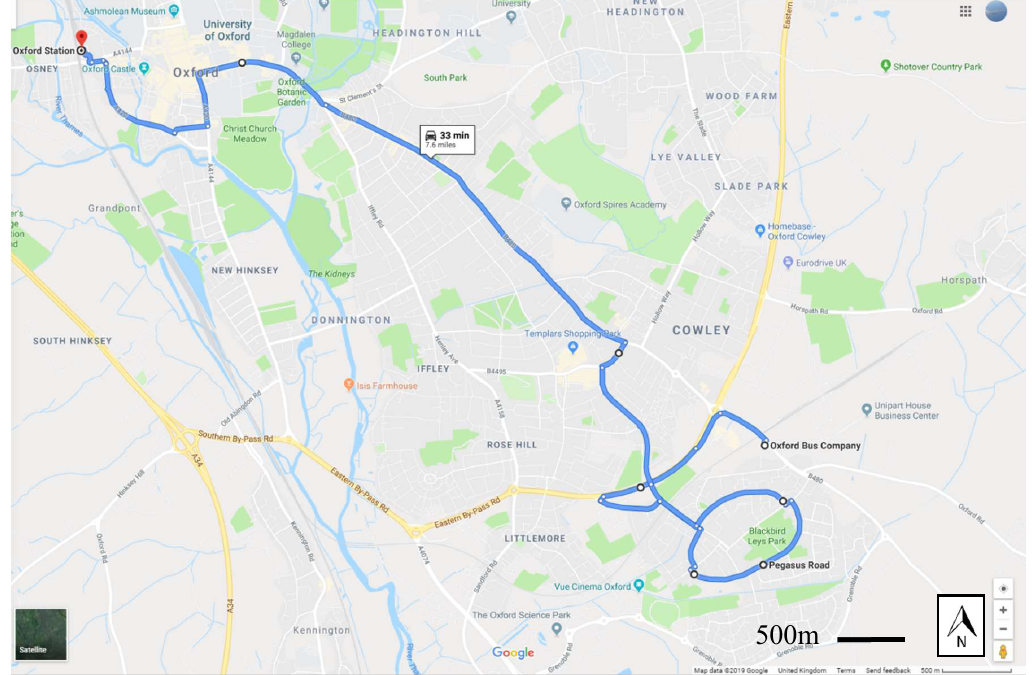
Figure 6. Route taken by Euro VI bus (map data © Google).